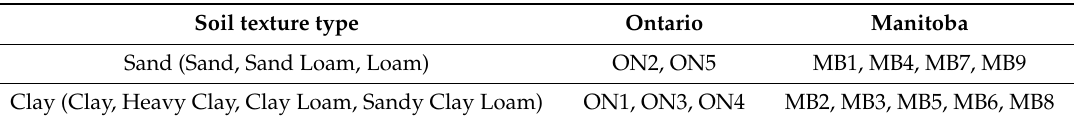
Table 1. Real Time In Situ Monitoring for Agriculture (RISMA) networks soil texture